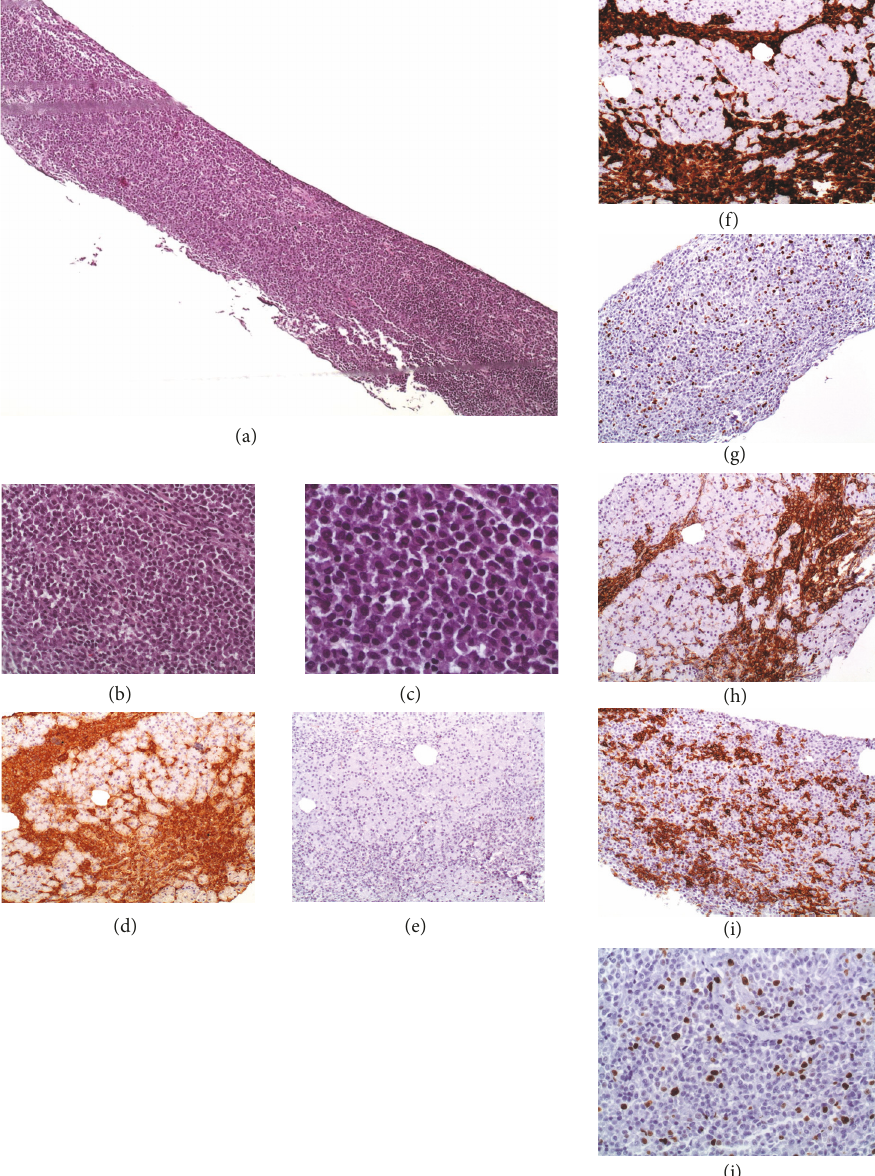
Figure 1: Plasma cells infiltration of pancreas allograft on indication biopsy due to elevation of amylase and lipase . (a–c) Extensive diffuse infiltration and pancreatic tissue replacement with plasma cells observed on H&E ((a): X40; (b): x200; (c): x400). (d) Extensive immunostaining for IgG-kappa chains, x100; (e) absence of lambda staining, x100; (f) immunohistochemicalstaining were positive for CD79 plasma cells, x100; (g) negative for CD20, x100; and (h) extensively positive for CD138, x100; (i) and (j) Ki67 proliferation index was under